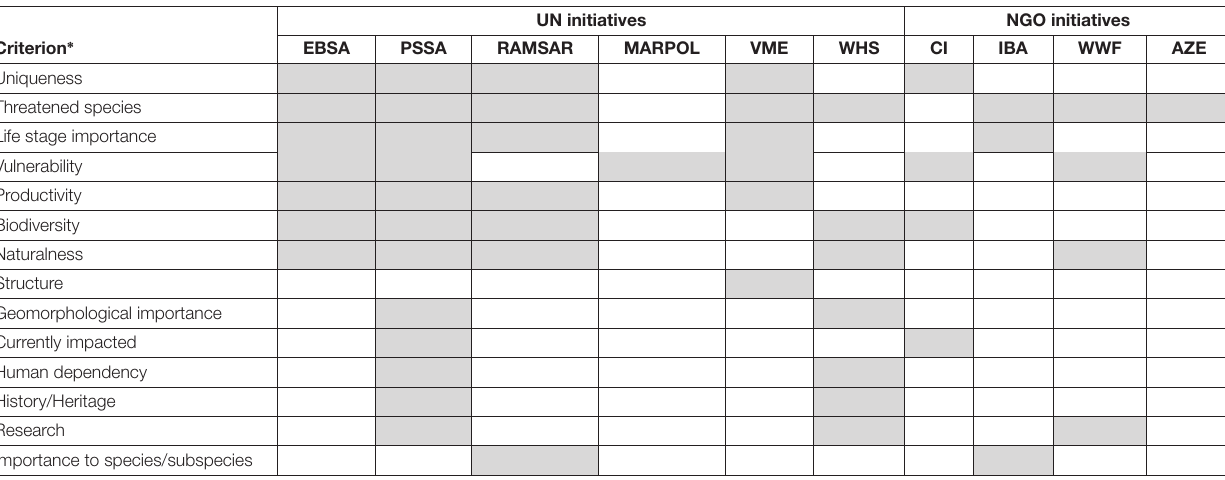
TABLE 1 | Criteria used by ten initiatives to map important marine